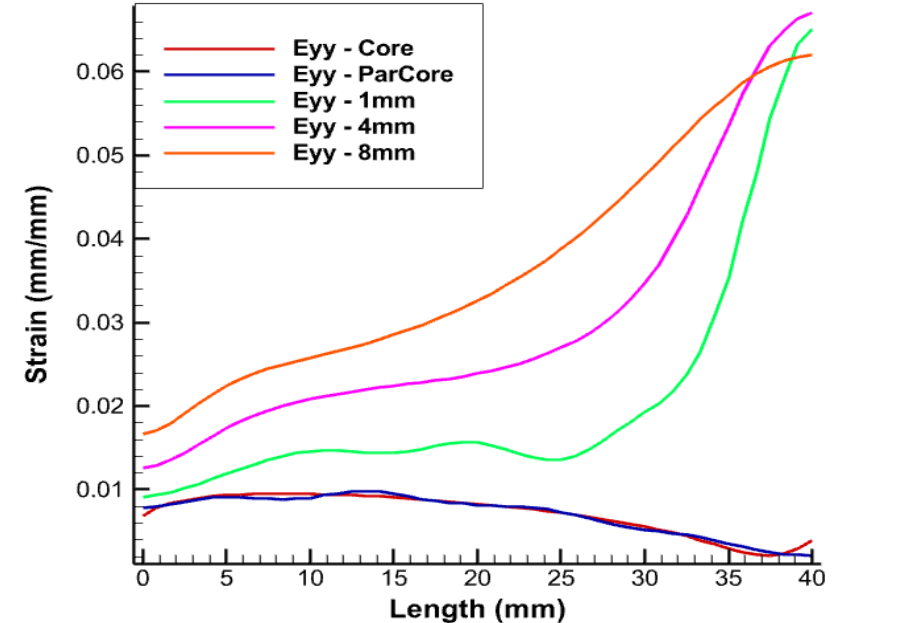
Figure 11. E yy strain for pure tension test